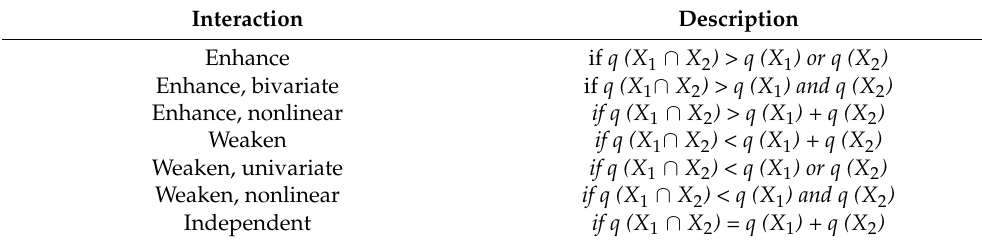
Table 5. Interaction relationships between two